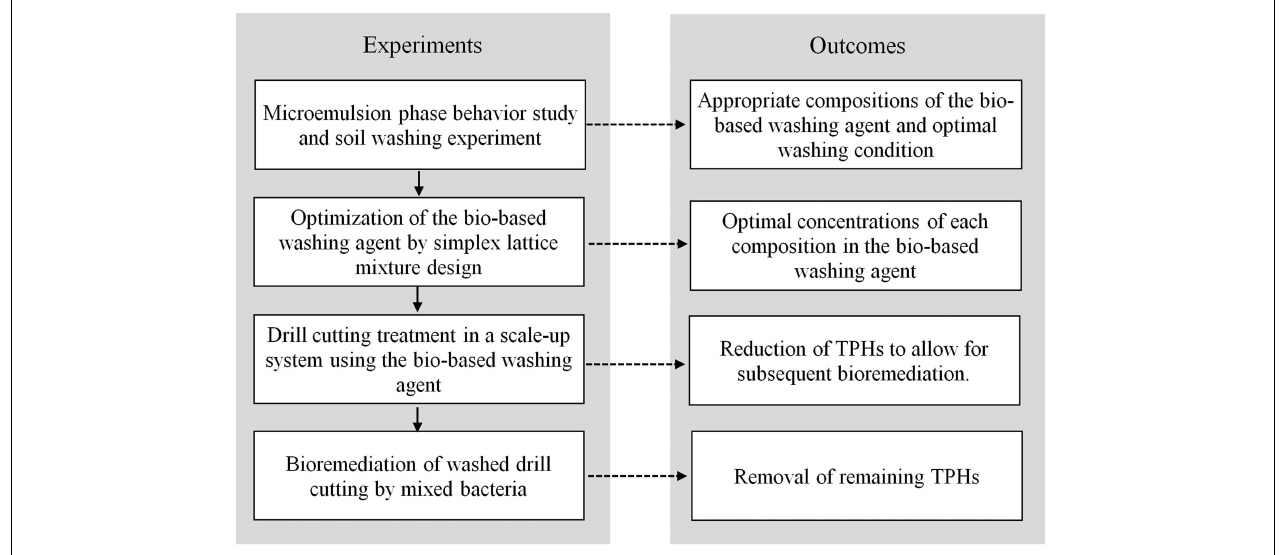
FIGURE 1 | Flowchart of experimental procedure and outcomes.